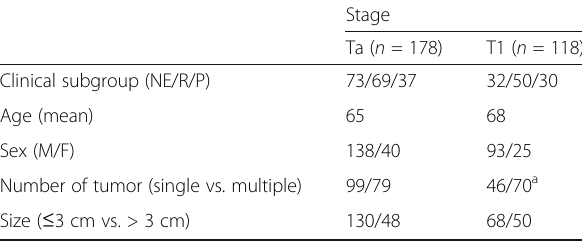
Table 1 Clinical characteristics of the